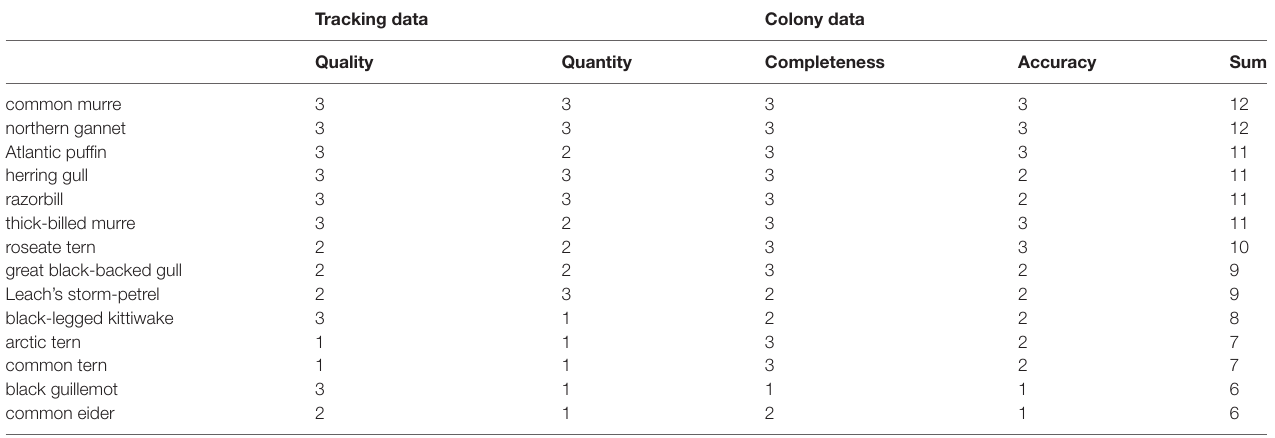
TABLE 4 | Qualitative assessment of the data used as inputs to the predictive distribution models. Tracking